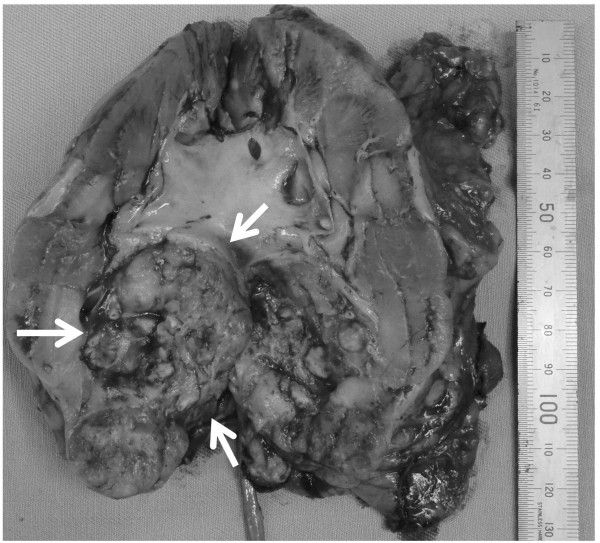
Macroscopic findings. Macroscopic examination reveals a solid tumor measuring 4 × 2.5 cm in size in the lower pole of the resected kidney (arrow).